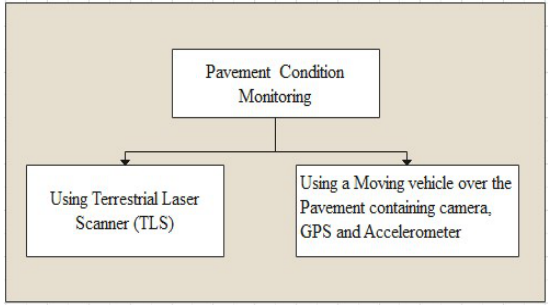
Figure 3 . Data collection Methods.